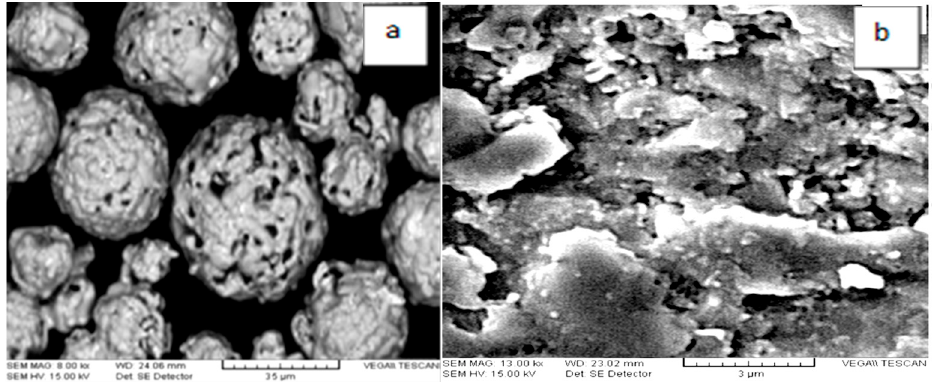
Figure 5. Chromium Carbide coating: ( a ) powder form; ( b ) cross sectional image for chromium carbide coating (Yaghtin et al., 2015).